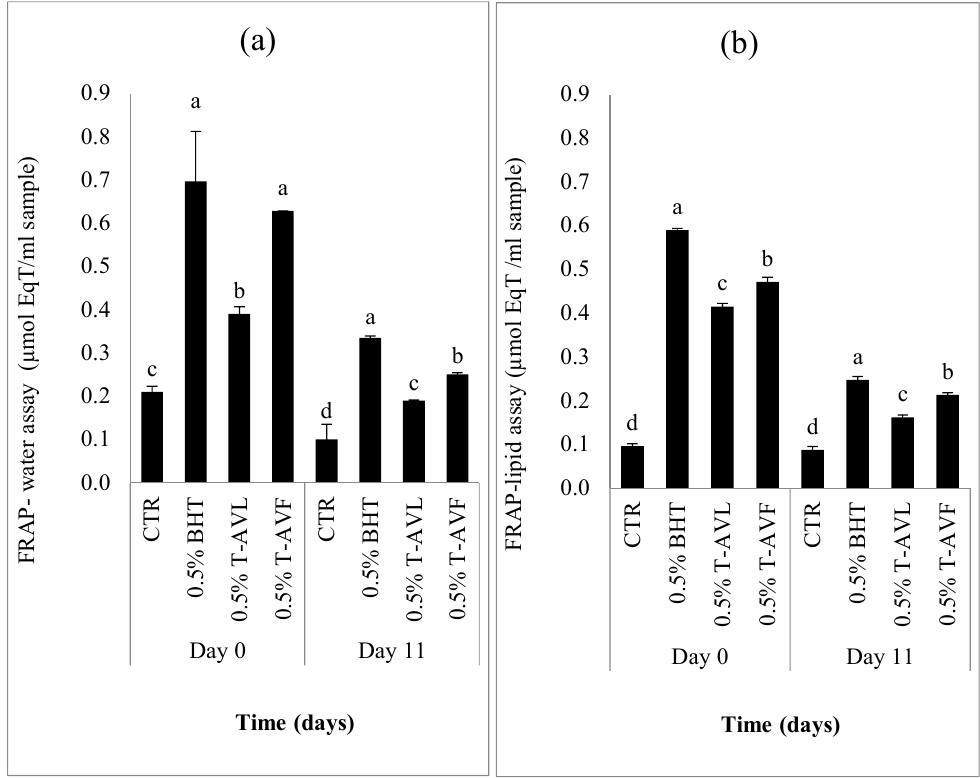
Figure 5. Antioxidant Capacity. (AOC) measurements by FRAP water ( a ) and FRAP lipid ( b ) assays of each beef patty sample formulated with powdered leaf and flower of A. vulneraria. CTR (Control sample without antioxidant), 0.5% BHT (treatment with 0.5% synthetic antioxidant (Butylated hydroxytoluene)), 0.5% T-AVL (treatment with 0.5% A. vulneraria leaf), 0.5% T-AVF (treatment with 0.5% A. vulneraria flower). Results represent the mean of three replicates and are expressed as mean value ± SD; different letters in the same day indicate significant difference between samples at p < 0.05.